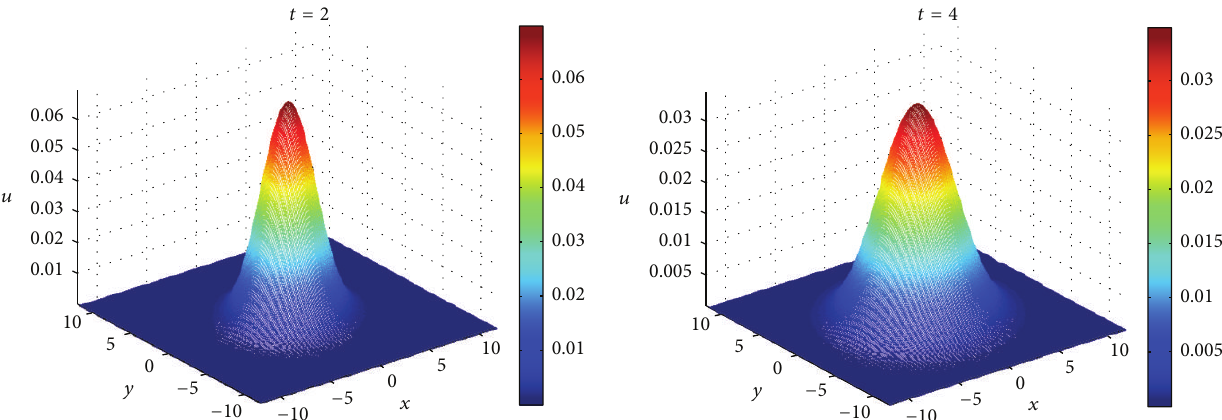
Figure 3: Persistence and existence of two-dimensional KiSS model (34) with initial population (35) at different time 𝑡 levels. Parameters are 𝛿 = 0.5 , 𝑝 = 2 , 𝜏 = 2.5 , and 𝐿 = 12